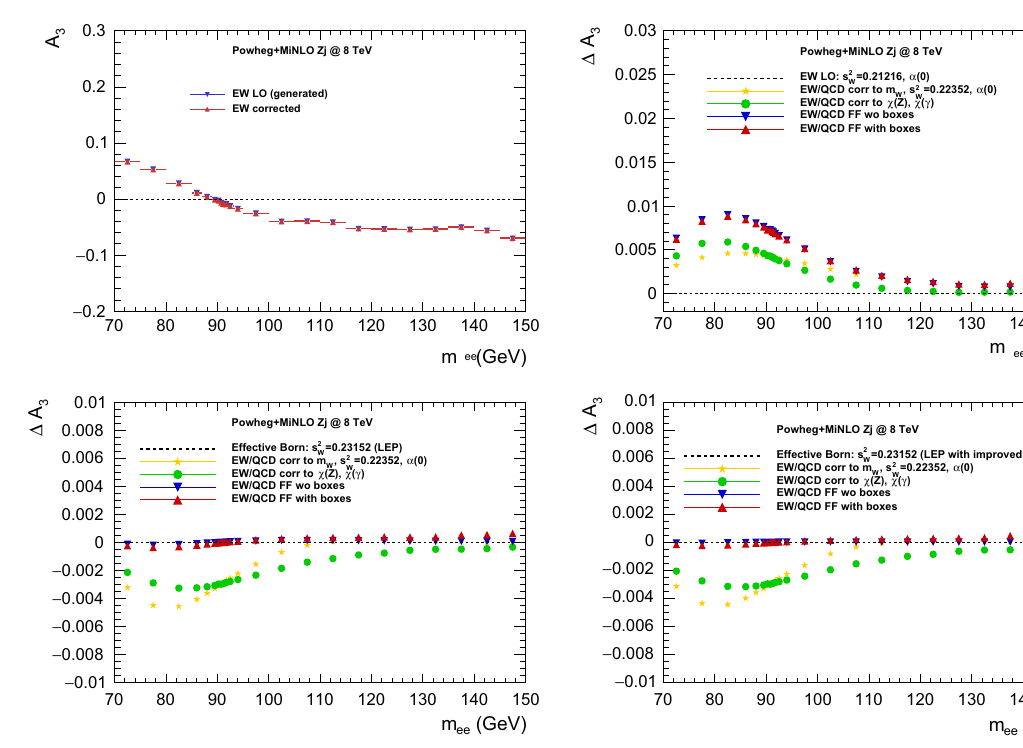
Fig. 8 Top-left:the A 3 asfunctionof m ee .Overlayedaregeneratedand (black dashed line) respectively (i) EW LO α( 0 ) scheme (top-right), (ii) EW corrected A 3 predictions. These results are barely distinguishable. effective Born ( LEP ) (bottom-left) and (iii) effective Born ( LEP with improved norm. ) (bottom-right) was used. In this case, the EW weight The differences (cid:8) A 3 = A 3 − A ref due to gradually introduced EW 3 is calculated with cos θ Mustraal corrections are shown in consecutive plots, where as a reference A ref 3 < 30 GeV and 80 < m < 100 GeV ranges. The cos θ CS is used for Table 9 The (cid:8) A 3 shift of the A 3 , due to EW corrections, averaged over p ee ee T angular polynomials but for the EW weight calculation cos θ ∗ , cos θ Mustraal or cos θ CS are used respectively < 30 Corrections to A 3 ( p ee T